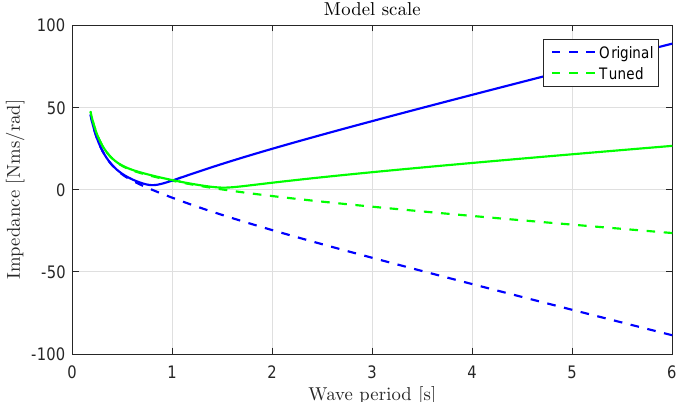
Figure 5. Reactance (dashed) and optimal load resistance (solid) estimated for the system under the assumption of no losses for both a system with original configuration (blue) and a system with stiffness tuned to give resonance at T 0 = 1.5s (green). The large-mass system has been assumed, cf. Table 2.